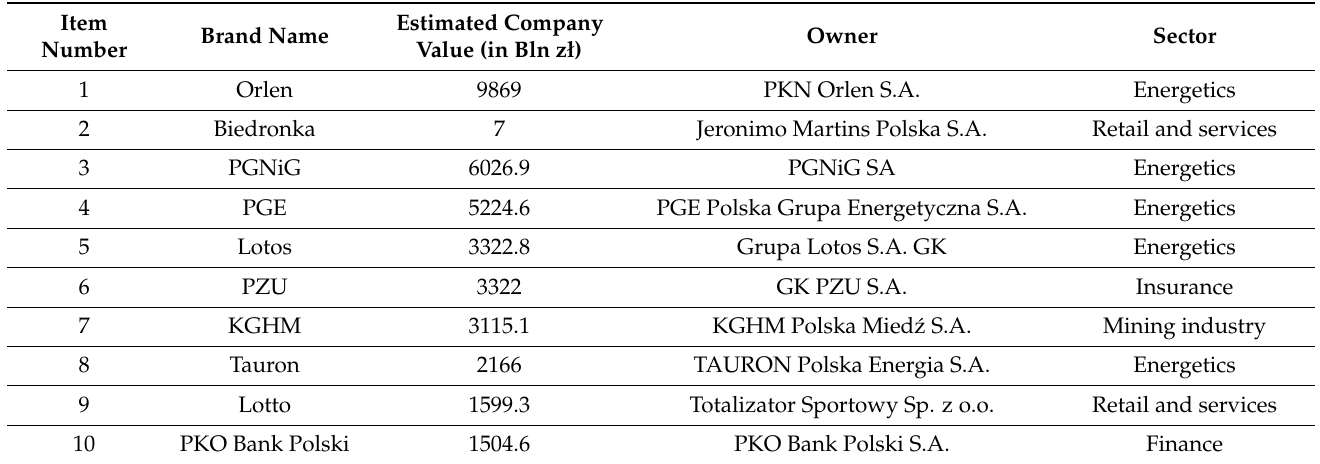
Table 5. List of the most lucrative Polish brands in